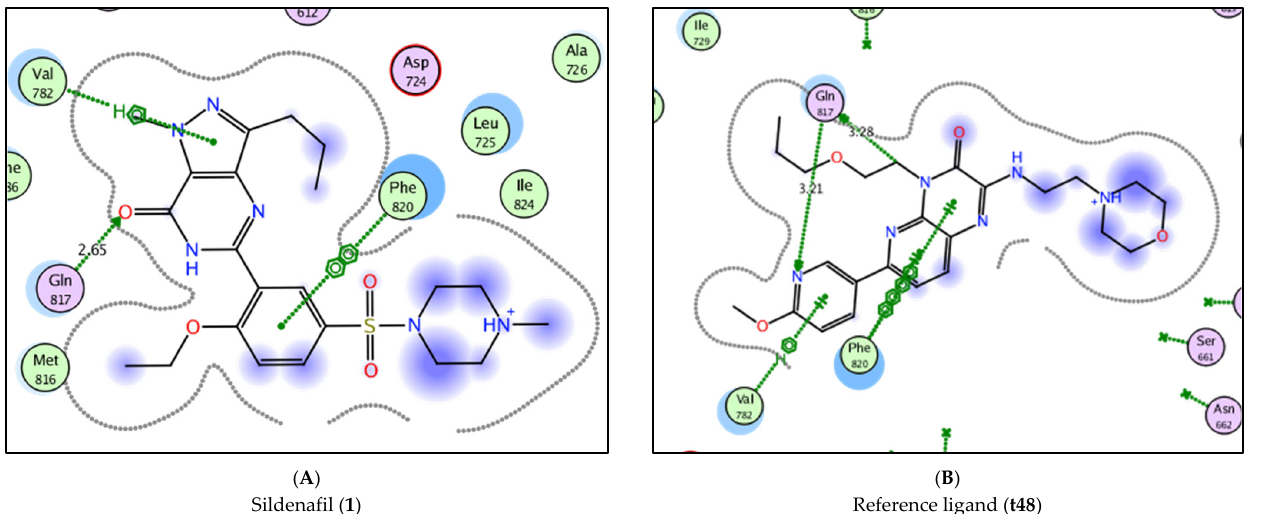
Figure 7. 2D interaction of sildenafil ( 1 , A ) and reference ligand ( t48 , B ) with PDE5 protein domain (PDB ID: 3HC8). Table 2. Binding interactions and docking scores of sildenafil ( 1 ), reference ligand ( t48 ) and the test Scheme 5 active